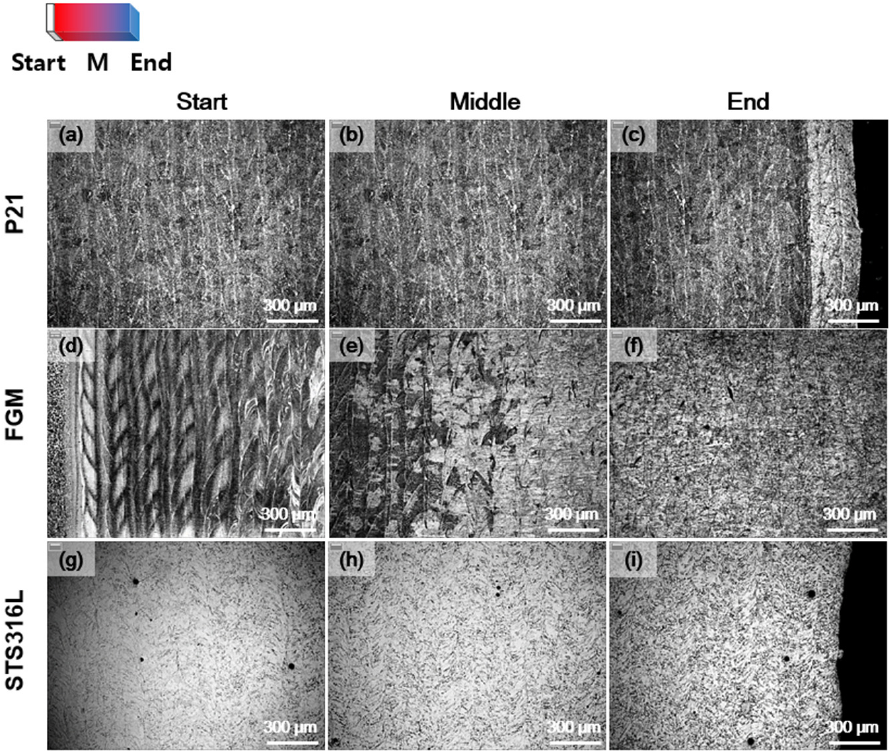
Figure 7. 50x OM microstructure images of P21, FGM and STS316L DED samples: ( a ) P21 start; ( b ) P21 middle; ( c ) P21 end; ( d ) FGM start; ( e ) FGM middle; ( f ) FGM end; ( g ) STS316L start; ( h ) STS316L h; ( i ) STS316L end.